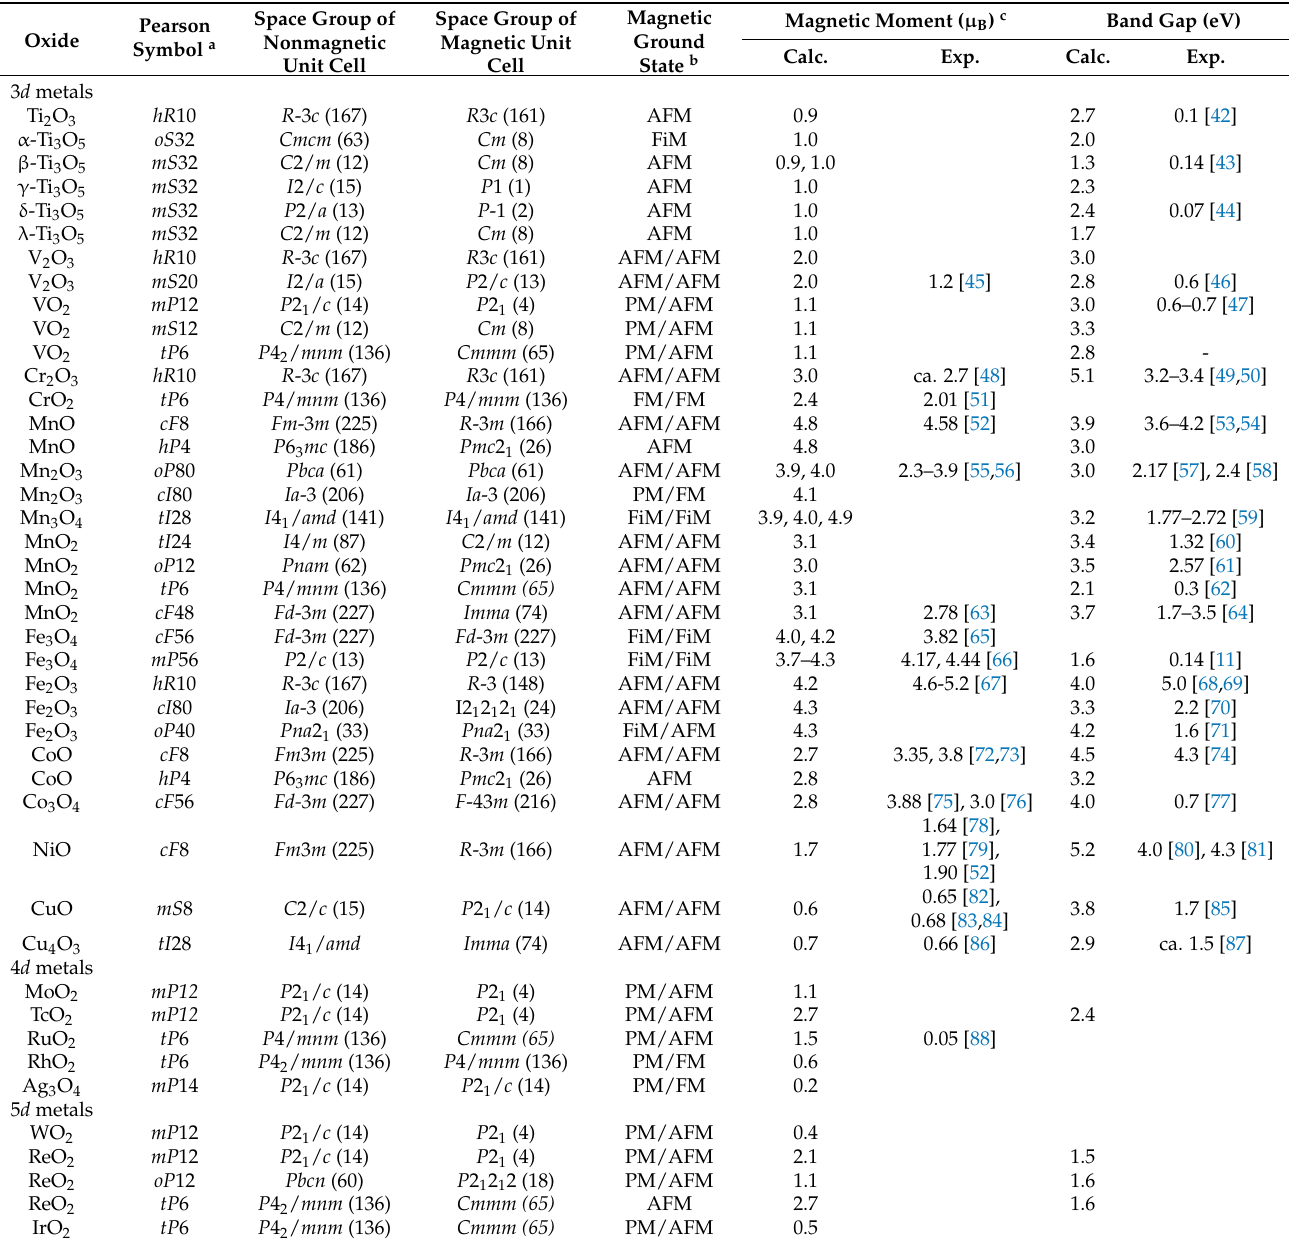
Table 1. Pearson symbols, space groups, magnetic ground states, spin magnetic moments for the metal atoms ( µ B ), and band gaps of the studied magnetic binary d -metal